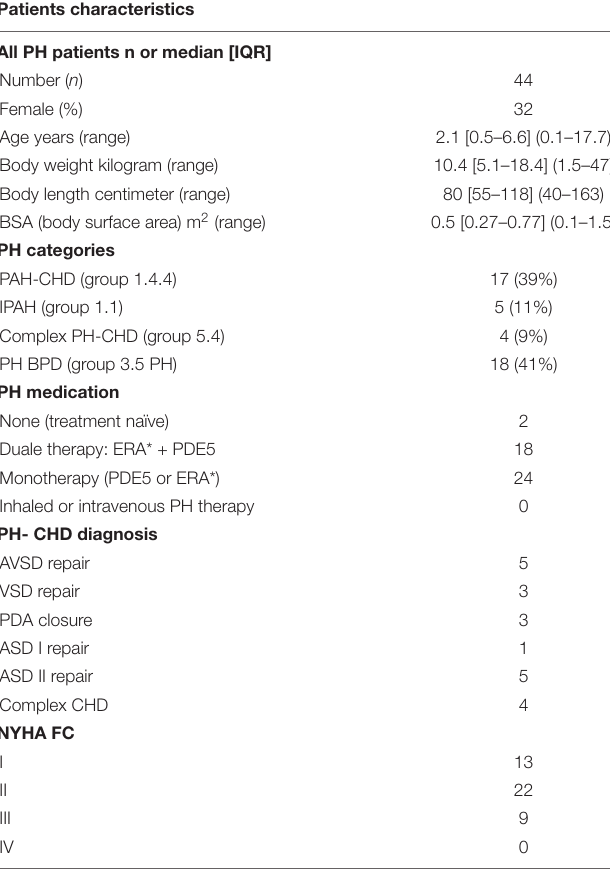
TABLE 1 | Demographic data of the children with pulmonary hypertension (PH). Patients